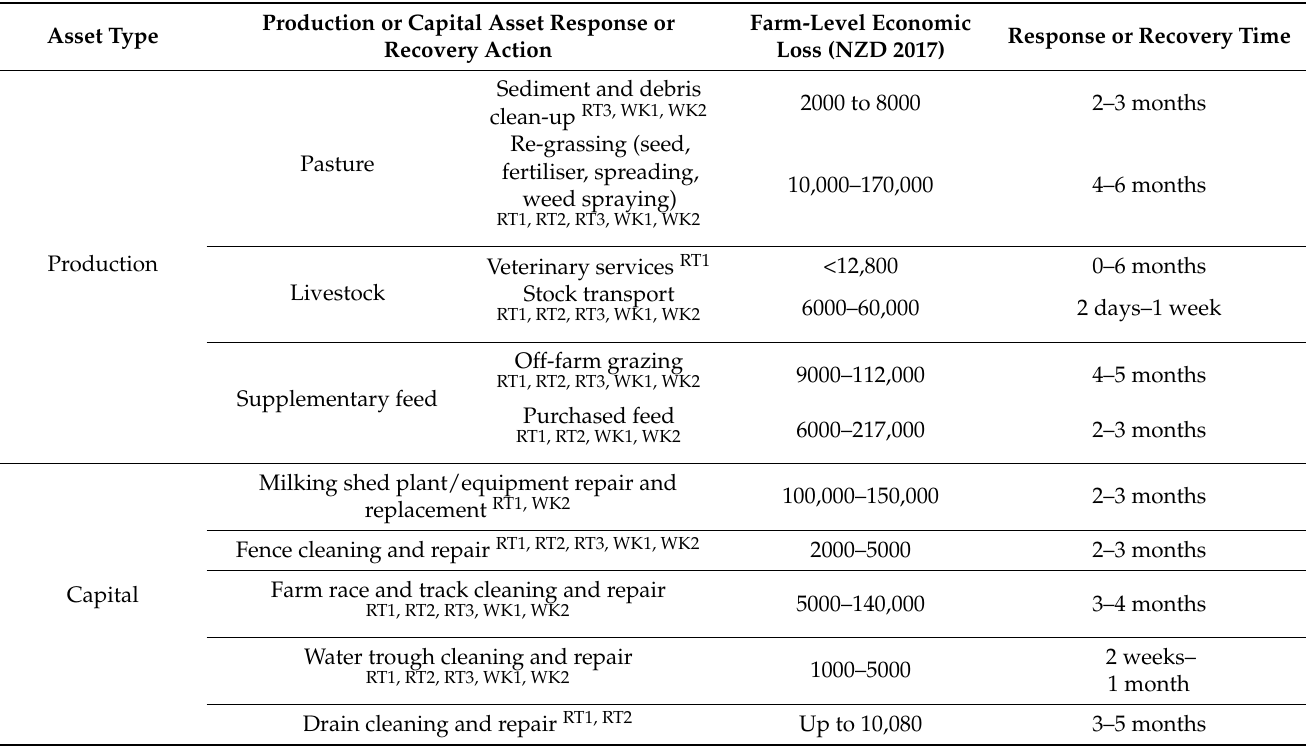
Table 4. A summary of flood hazard exposure and damage response and recovery actions with associated farm-level economic loss time estimates reported as an addition to “normal operating” activities on surveyed Bay of Plenty region dairy